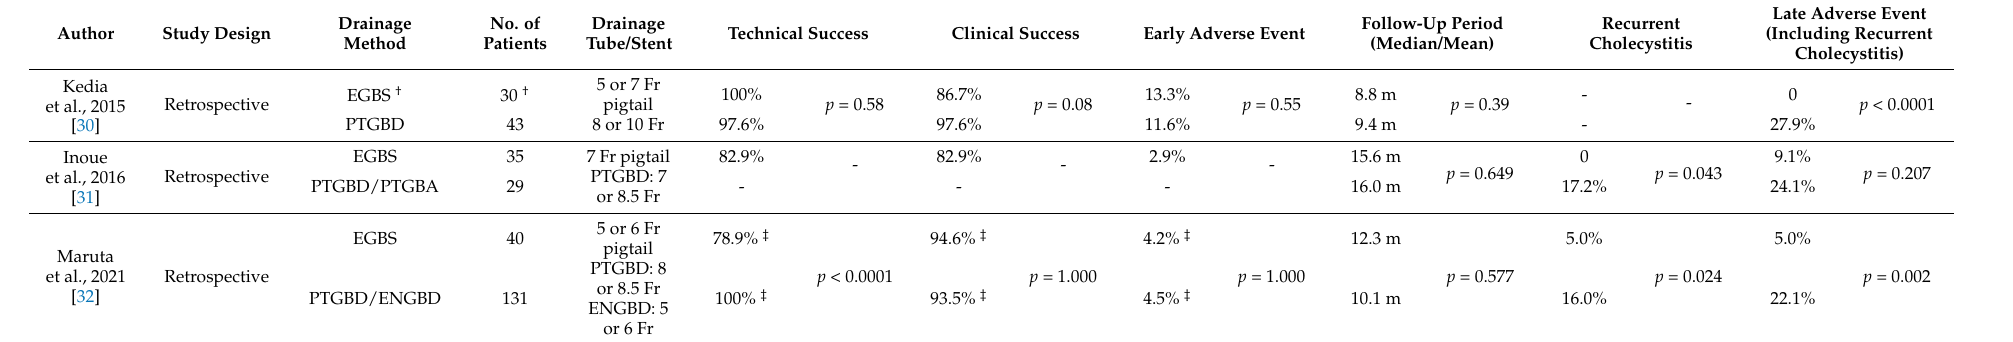
Table 1. Studies comparing long-term outcomes of endoscopic gallbladder stenting and percutaneous